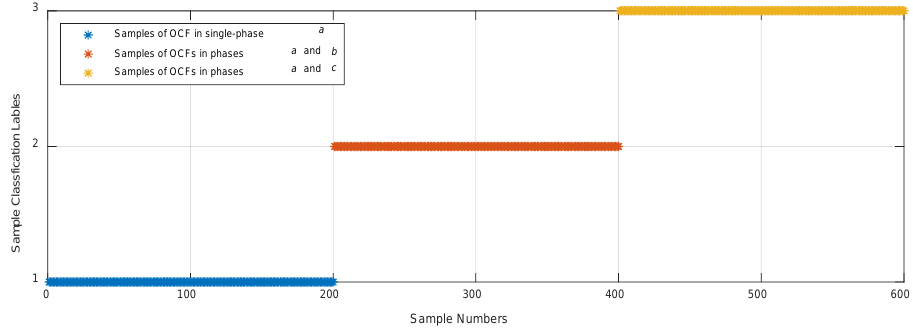
Figure 11. The 600 samples with their corresponding labels.